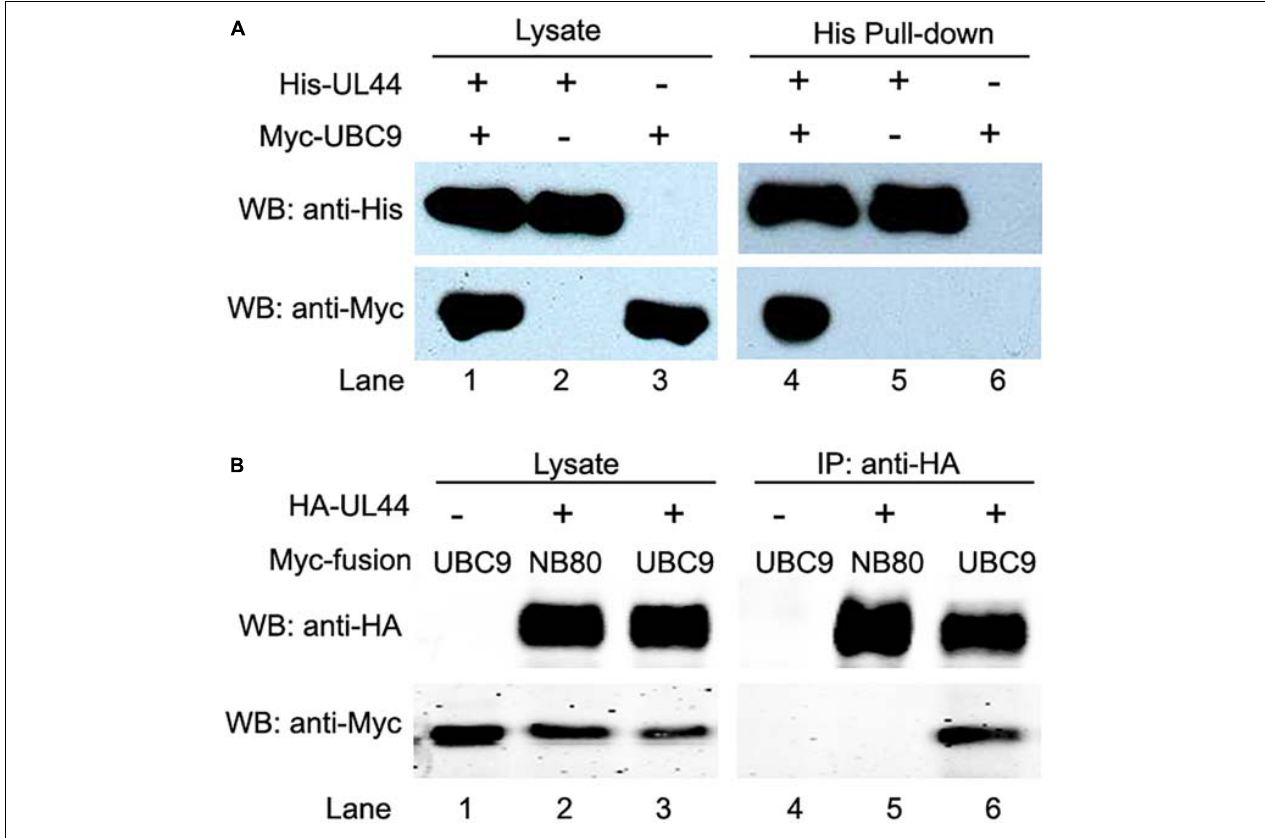
FIGURE 1 | HCMV UL44 interacts with UBC9 in vitro and in vivo . (A) His-tagged UL44 pulled down Myc-tagged UBC9 in vitro . His-UL44 were bound to immobilized cobalt chelate resin then incubated with cell lysates expressing Myc-UBC9. The bound protein complexes were analyzed by western blot using anti-His and anti-Myc antibodies. Representative of three independent experiments. (B) Co-IP of transiently expressed UL44 and UBC9. 293T cells were cotransfected with HA-tagged UL44 and Myc-tagged UBC9 or NB80 as negative control. Cell lysates were incubated with immobilized anti-HA beads to isolate UL44 and its associated proteins. Results were analyzed by western blot using anti-HA and anti-Myc antibodies. Representative of three independent